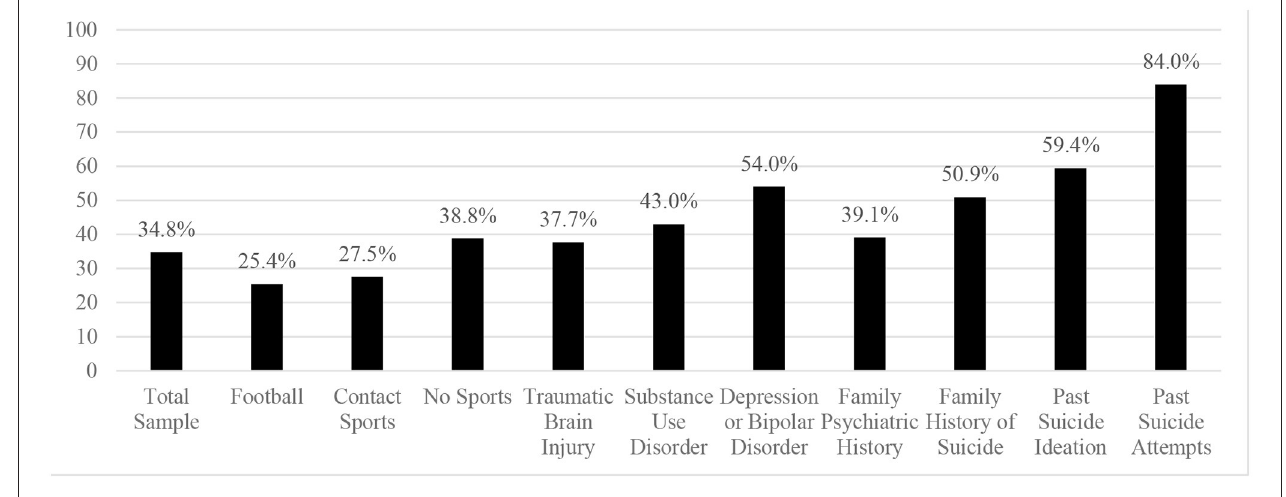
FIGURE 1 | Suicide as a manner of death stratified by